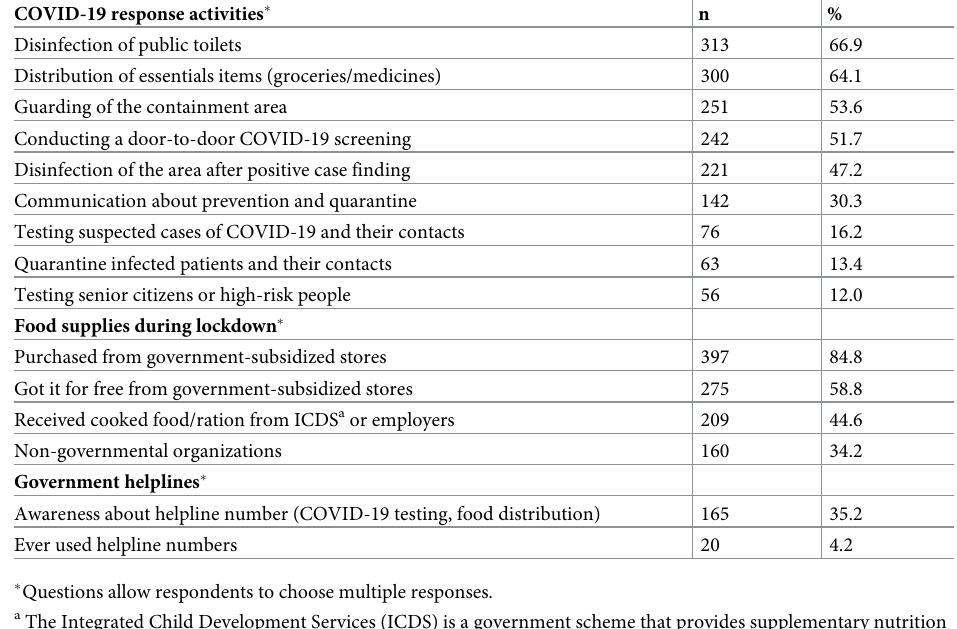
Table 6. COVID-19 response activities by the local administration as reported by survey participants among Dharavi residents, Mumbai, India (N =